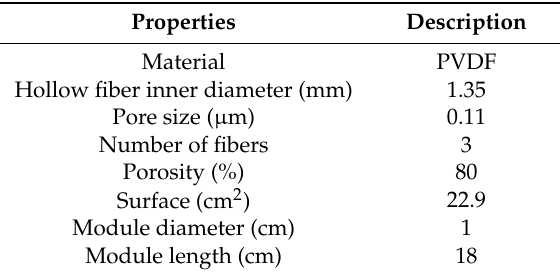
Table 2. Properties of the hollow-fiber membrane contactors module.